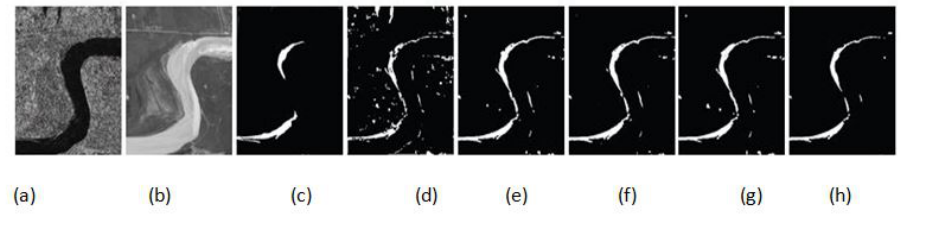
Figure 8. CD results for the heterogeneous images. ( a , b ) Images acquired by different observation